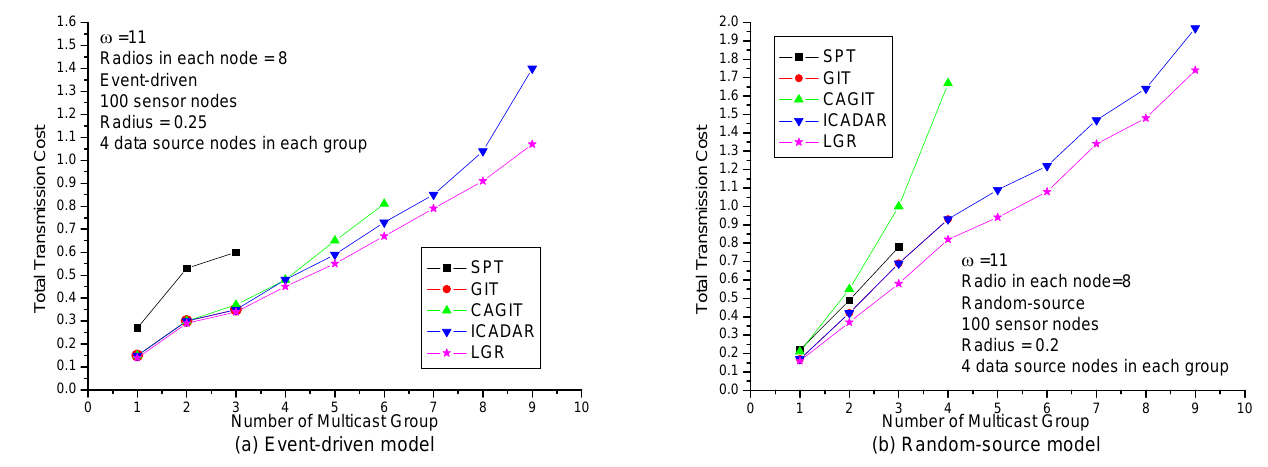
Figure 7. Performance comparison with respect to traffic